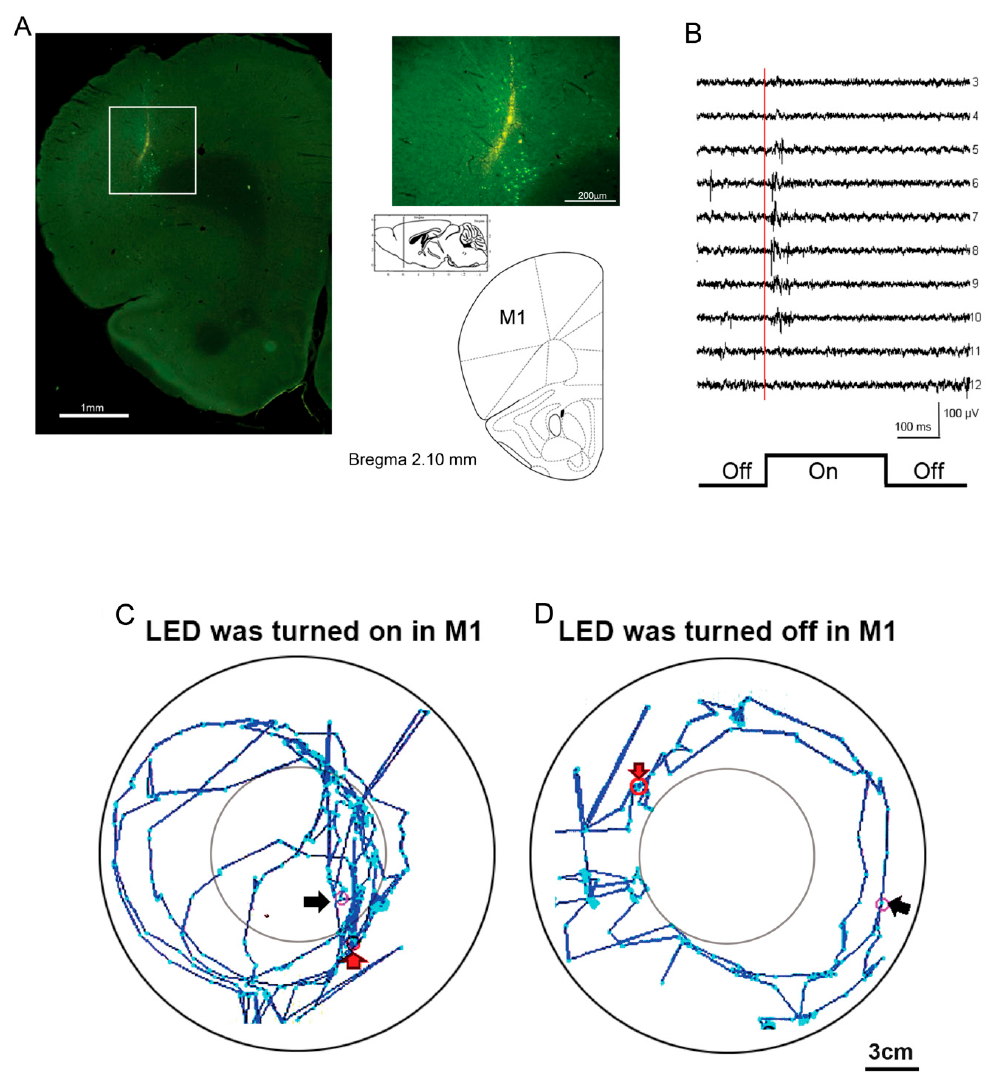
Figure 5. Optogenetic photostimulation outcomes to test locomotor activity in the open field task. ( A ) The Channelrhodopsin-2 (ChR2) transfection in the primary motor cortex (M1). Left: The whole view of the brain section. Right: The enlarged portion of the square on the left and the atlas show the relative section in sagittal and coronal views, +2.10 mm rostral to bregma. ( B ) An example of multichannel neuronal unit activity recording in the M1. The marker indicated the turning on of the optogentic stimulation. ( C ) The picture shows the LED light turned on in M1, the primary motor cortex. ( D ) The picture shows the LED light turned off in M1, the primary motor cortex. The black arrow represents the starting point and the red arrow represents the ending point.